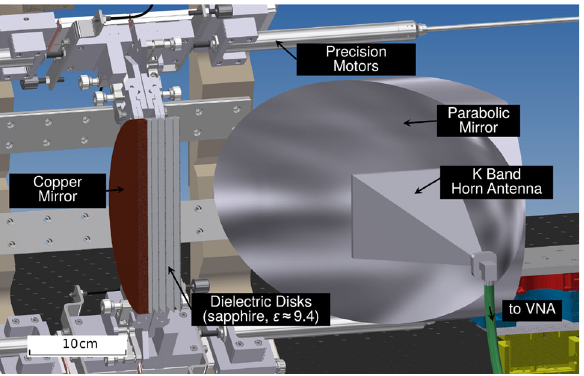
Fig. 4 Schematic drawing of the proof of principle setup. Up to 5 sapphire disks with a diameter of 20cm each are mounted in front of a plane copper mirror and can be moved using precision motors. Test beam reflections are studied via the parabolic-mirror-antenna assembly and measured with a vector network analyzer (VNA). For clarity we only show a cross section orthogonal to the disk surfaces. The distance between the booster and the antenna is adjusted to ∼ 70cm in our setup (shorter in this drawing for illustration purposes). The rest of the figure is to